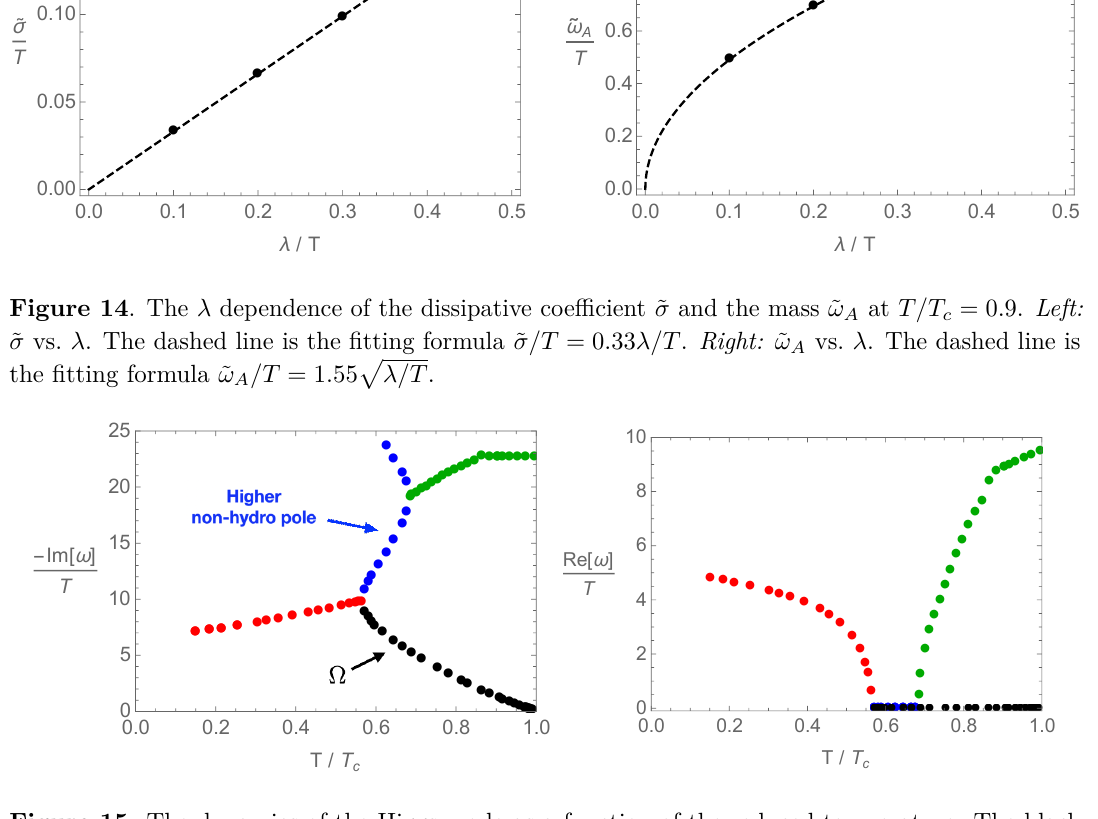
Figure 15 . The dynamics of the Higgs mode as a function of the reduced temperature. The black dots encode the fluctuations of the amplitude of the order parameter close to the critical